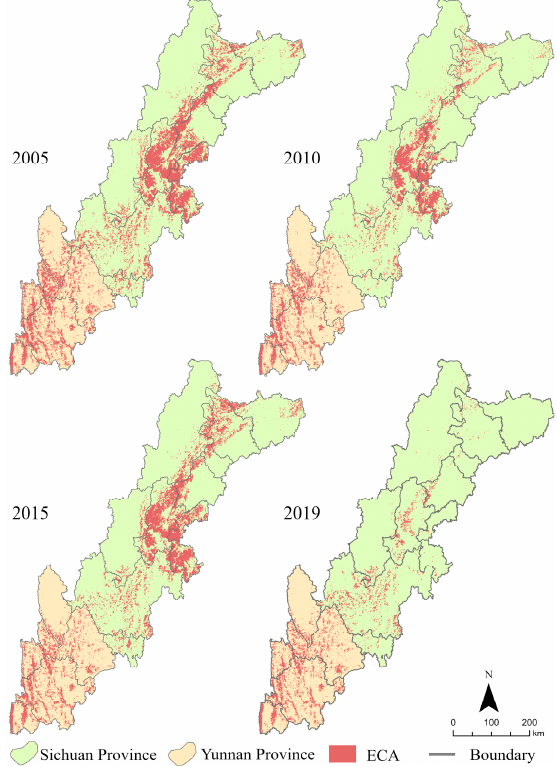
Figure 5. Spatial-temporal distribution of ECA.